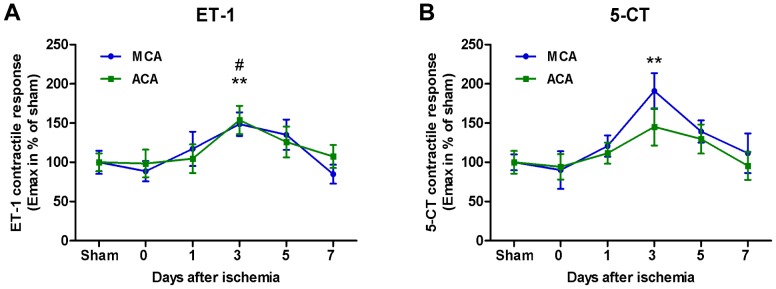
Time-course of enhanced cerebrovascular contractile responses after global cerebral ischemia.Graphs summarizing concentration-contractions curves elicited by cumulative application of ET-1 (A) and 5-CT (B) to MCAs and ACAs from control rats (sham) or rats subjected to ischemia and reperfusion for 0, 1, 3, 5 or 7 days. The maximum contraction for Emax(1) and Emax(2) were calculated for each agonist at each post-ischemic day and normalized to the corresponding sham levels and the Emax value on the Y axis represents a mean value received from a composition of both Emax(1) and Emax(2). n = 3–15 rats in each group. Asterisks (* for MCA and # for ACA) indicate significant differences between sham and ischemia as determined by Student's t-test.